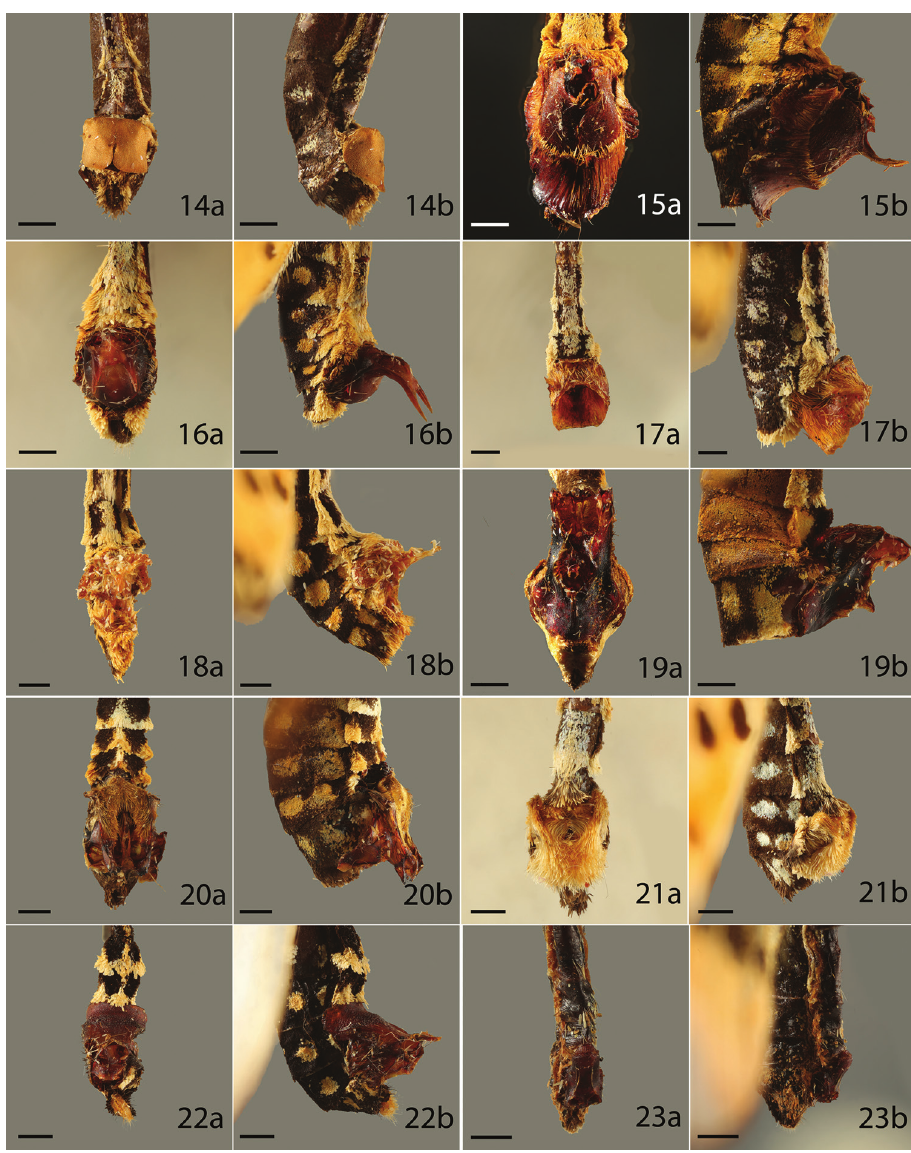
Figures 14–23. Sphragis of butterfly species, a ventral, b lateral, category of the sphragis in